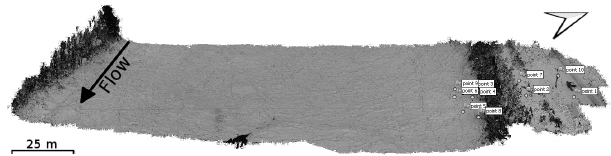
Figure 5. Example point cloud: DRLL06, 21 November